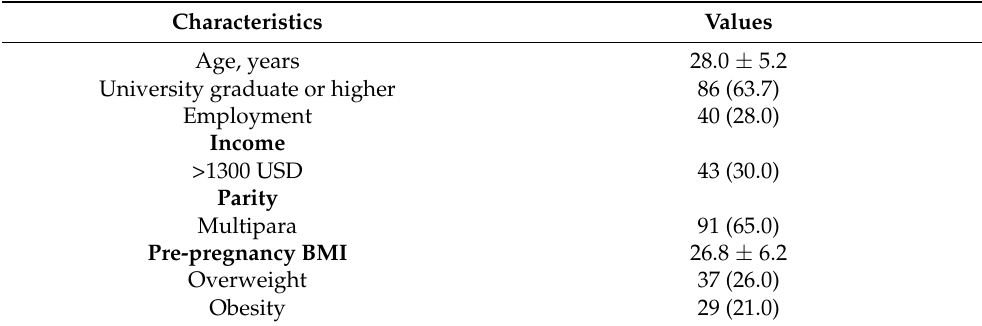
Table 1. Demographic and clinical